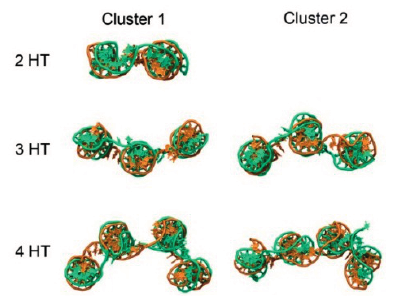
Figure 4. Snapshots showing representative structures of the first two conformational clusters from MD trajectories of weave tiles. According to the clustering metric used, 2HT had a total of 1 cluster, the 3HT had 5 and the 4HT had 7. The first cluster (Cluster 1) is the most common conformation of the tile, while Cluster 2 is the second most common conformation observed during